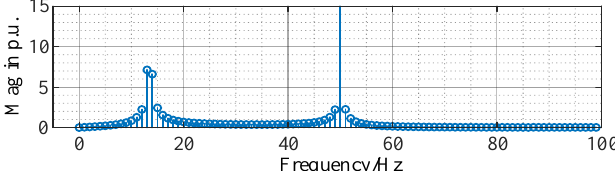
Figure 13. FFT analysis of resonant current in grid-converter interconnected system.